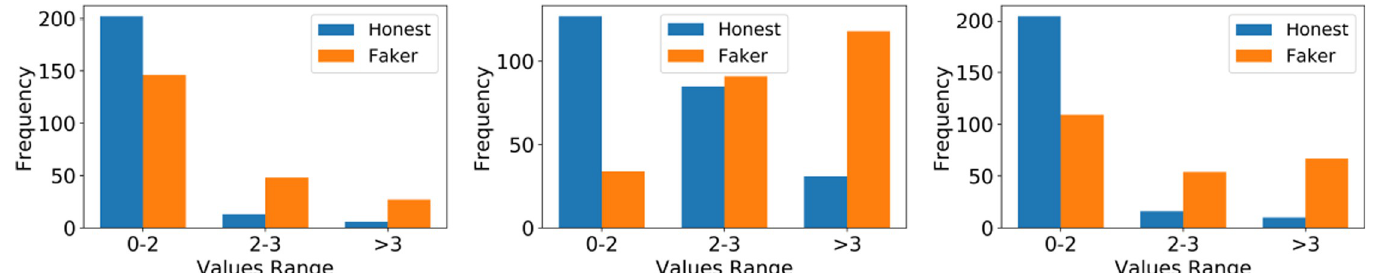
Fig 3. Average of TF-IDF response values over all 10 items for honest and dishonest response. Datasets from left to right: CC, JIS, JIHO. The odds for TF-IDF above 3 are the following: 1/3.8 (for every honest response with a TFIDF > 3, there are 3.8 Fakers for CC), 1/6.7 (for JIS), and 1/4.5 (for JIHO). Transforming odds to probabilities yields the following probabilities of dishonesty for TF-IDF > 3: 79.2% for CC, 87% for JIS, and 82% for